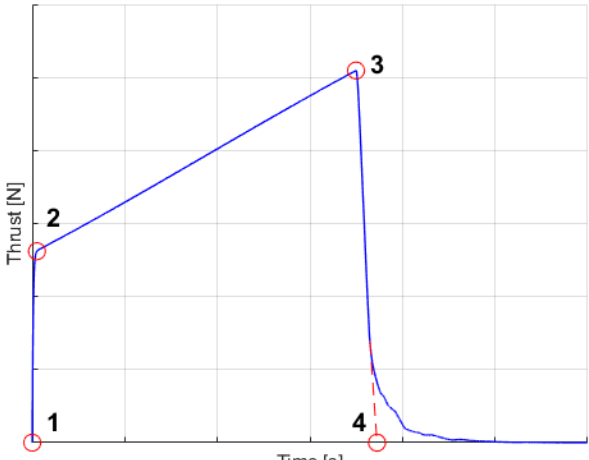
Figure 7. Thrust curve.